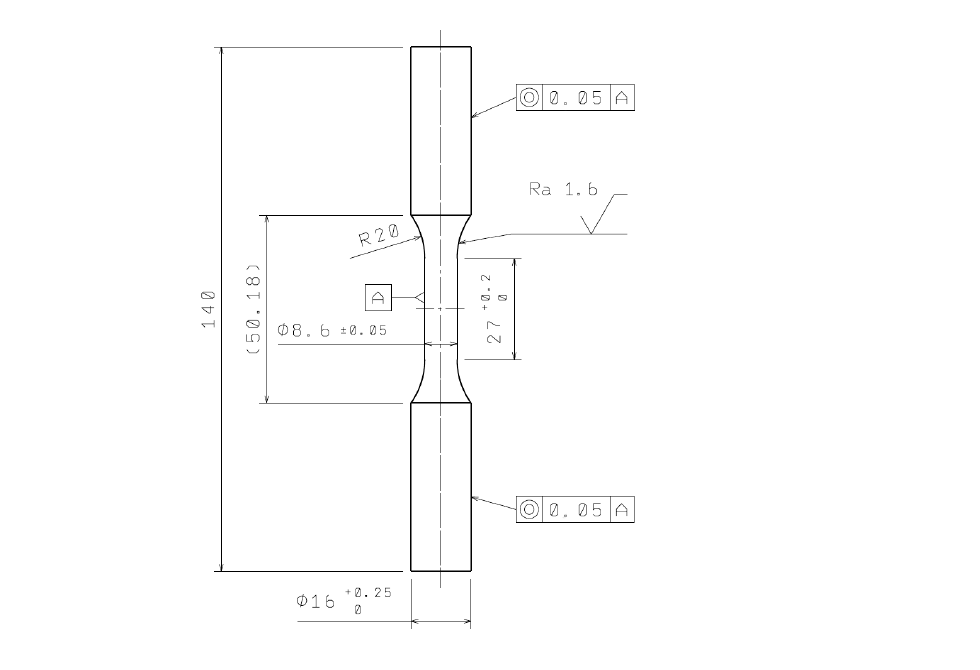
Figure 1. Geometry of dog-bone specimens for calculations of the strain-life models. Table 1. Strain-life test